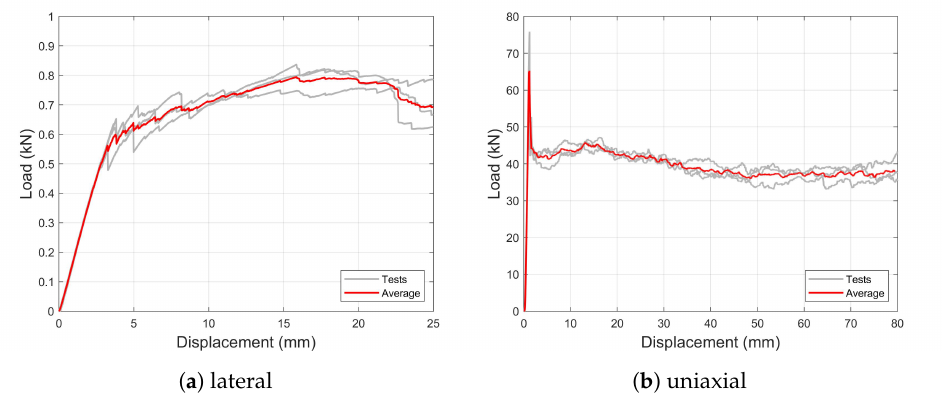
Figure 9. Load–displacement curves related to the lateral and uniaxial crush of hallow tubes.